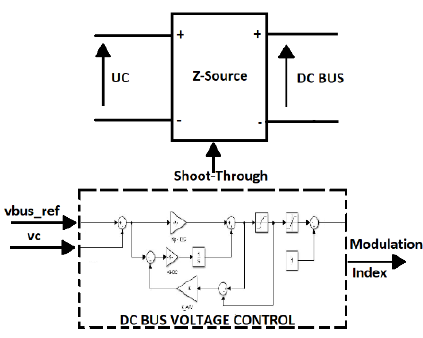
Figure 6. DC bus control structure.